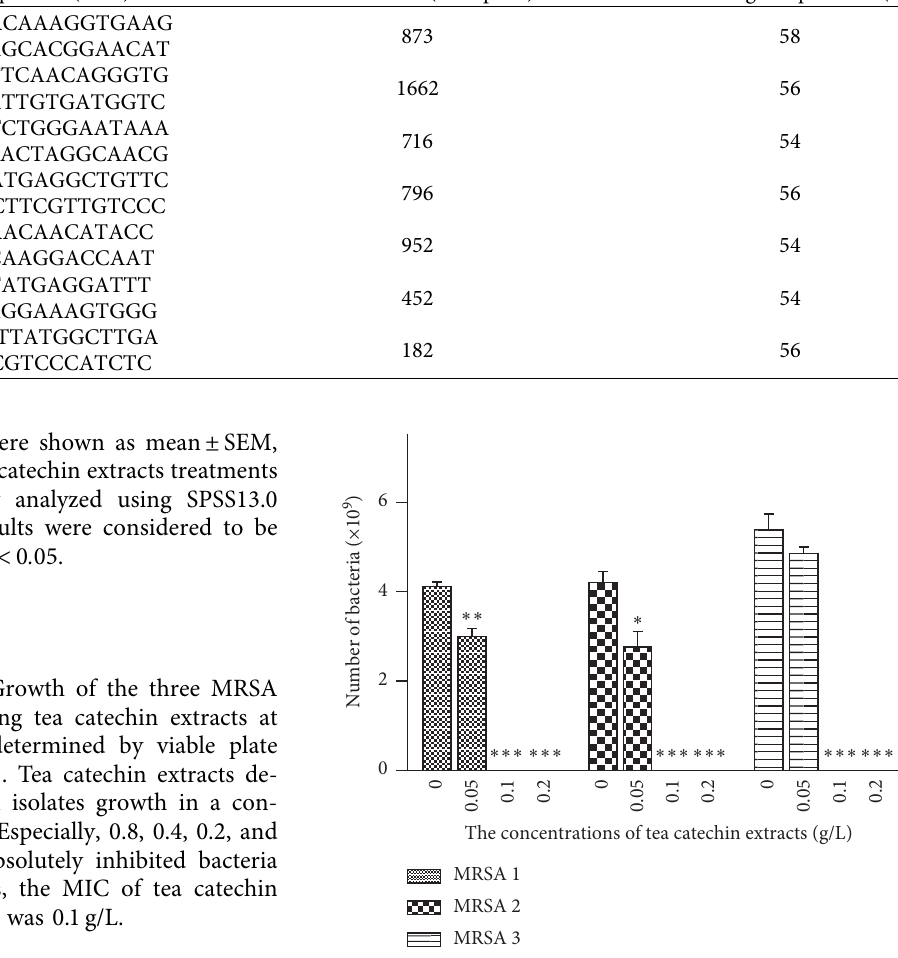
Table 1: Primers for amplification of the adhesin genes of Staphylococcus aureus . Gene Primer sequences (5 ′ -3 ′ )